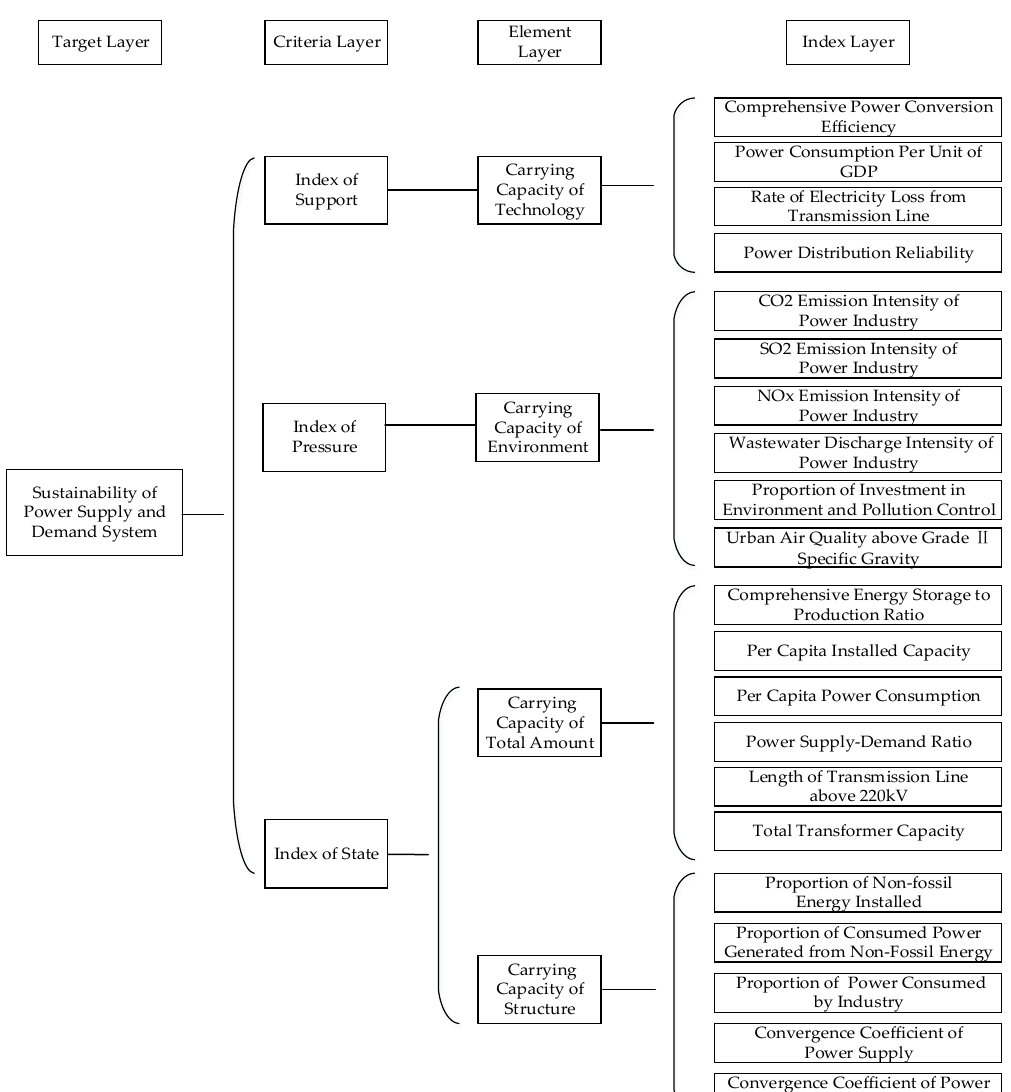
Figure 9. Index system for the evaluation of the sustainability of the power supply and demand system.